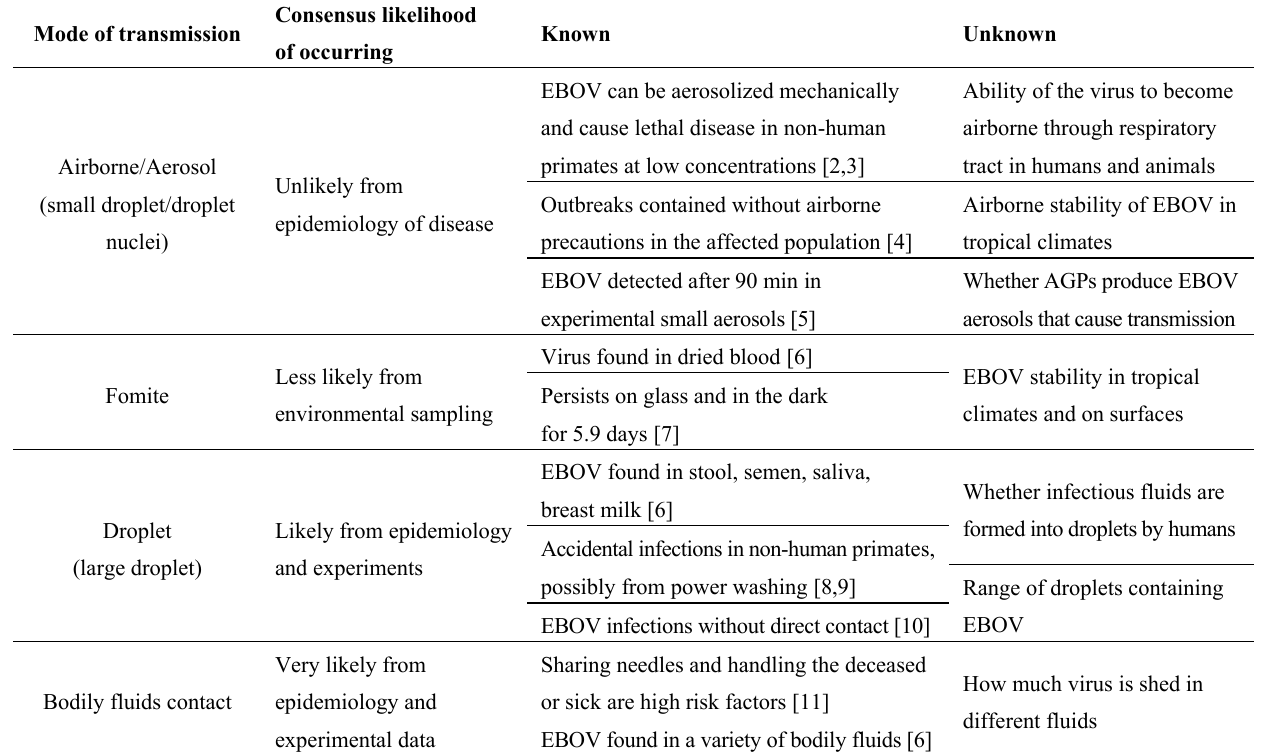
Table 1. Knowledge about different routes of Ebola virus